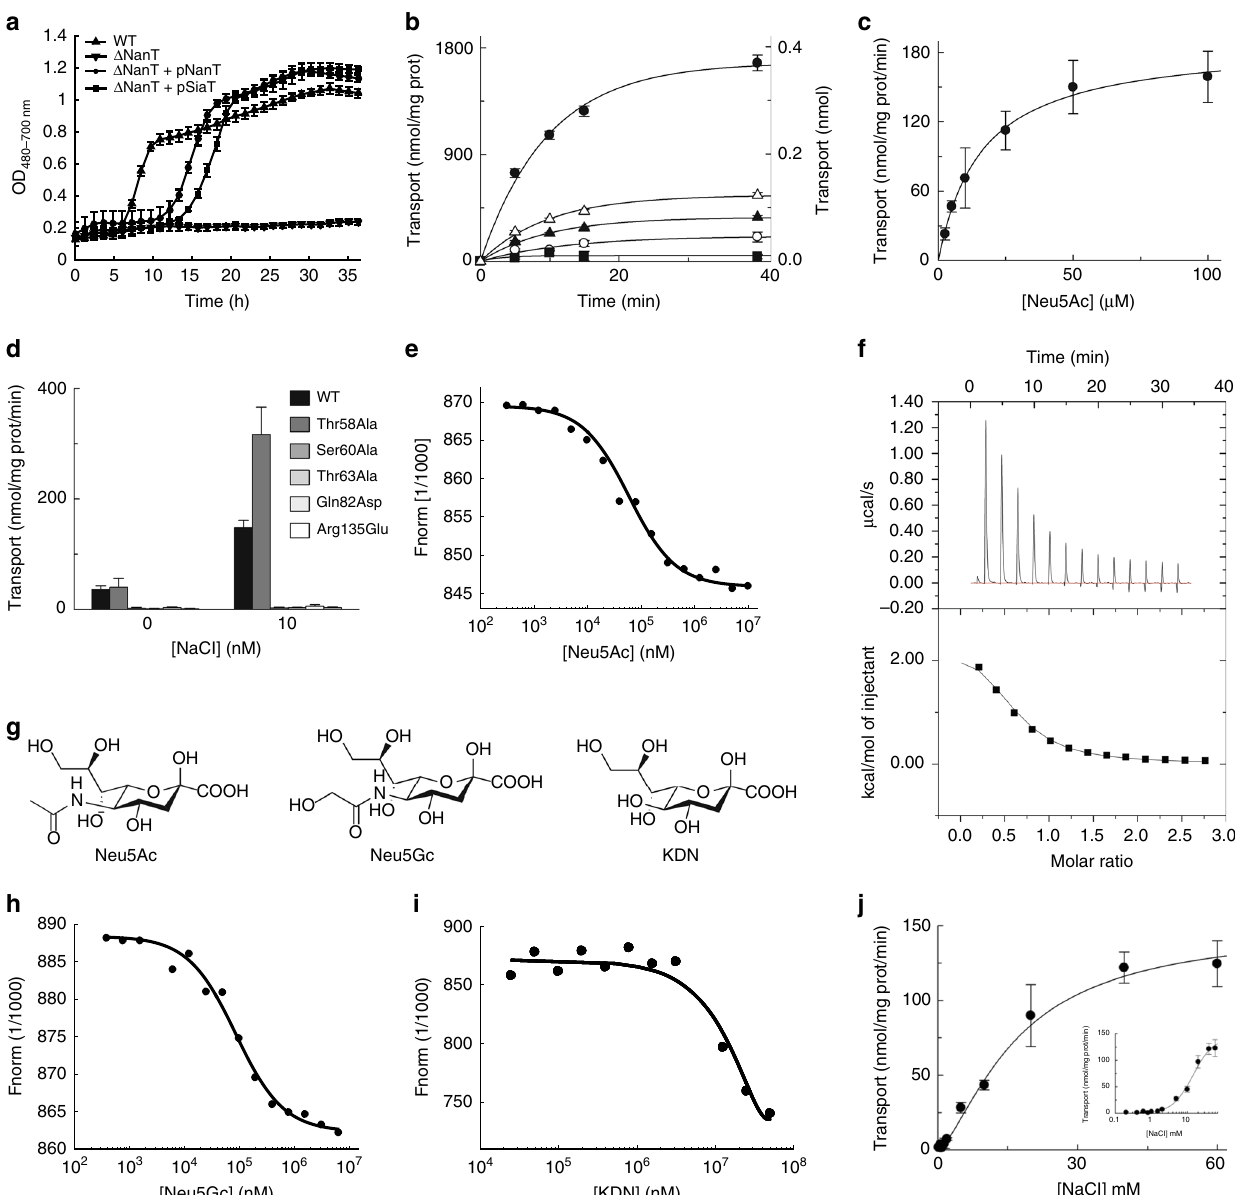
Fig. 2 Characterisation of SiaT. a SiaT is able to rescue growth of E. coli Δ NanT on Neu5Ac as the sole carbon source. The growth lag observed for Δ NanT + pNanT and Δ NanT + pSiaT is due to IPTG induction of the T5 promoter on pNanT and pSiaT. Growth curves represent the mean of six experiments ± SEM. b Time course of Neu5Ac uptake into proteoliposomes reconstituted with SiaT. In (black circle, black square, white triangle, black triangle), valinomycin was added to facilitate K + movement prior to transport. In (white circle), ethanol was added instead of valinomycin as a control. In (white circle, black square, black circle), 10 mM NaCl was added together with [ 3 H]-Neu5Ac; in (white triangle) 10 mM KCl was used in place of NaCl; in (black triangle) no salts were used in the transport assay. In (black square), transport was measured in empty liposomes. On the left Y -axis, speci fi c transport activity is reported; on the right Y -axis transport in empty liposomes. is reported. Uptake data were fi tted in a fi rst-order rate equation for time course plots. c The transport of [ 3 H]-Neu5Ac in the presence of 10 mM NaCl was measured in proteoliposomes reconstituted with SiaT, with an imposed K + diffusion membrane potential. Data were plotted using the Michaelis – Menten equation. d The kinetics of Neu5Ac transport by SiaT sialic acid binding site variants. The transport of [ 3 H]-Neu5Ac with or without NaCl was measured in proteoliposomes reconstituted with wild type and mutated variants, with an imposed K + diffusion membrane potential. All proteoliposome measurements ( b – d ) are presented as means ± SD from fi ve independent experiments. e MST binding assay of Neu5Ac binding to SiaT. f Representative isothermal titration calorimetry raw data (top) and binding isotherm (bottom) of Neu5Ac binding with SiaT. g Chemical structures of N -acetylneuraminic acid (Neu5Ac), N -glycolylneuraminic acid (Neu5Gc) and ketodeoxynononic acid (KDN). h , i MST binding assay of Neu5Gc ( h ) and KDN ( i ) binding to SiaT. j Determination of the SiaT Na + Hill coef fi cient. Data were plotted using the Hill equation. The inset represents the same data plotted using a log-scale for the X -axis to increase the resolution of low concentration data points. MST ( e , h , i ) and ITC ( f ) experiments represent the mean of three independent experiments ± SEM; for each, data from one representative experiment is